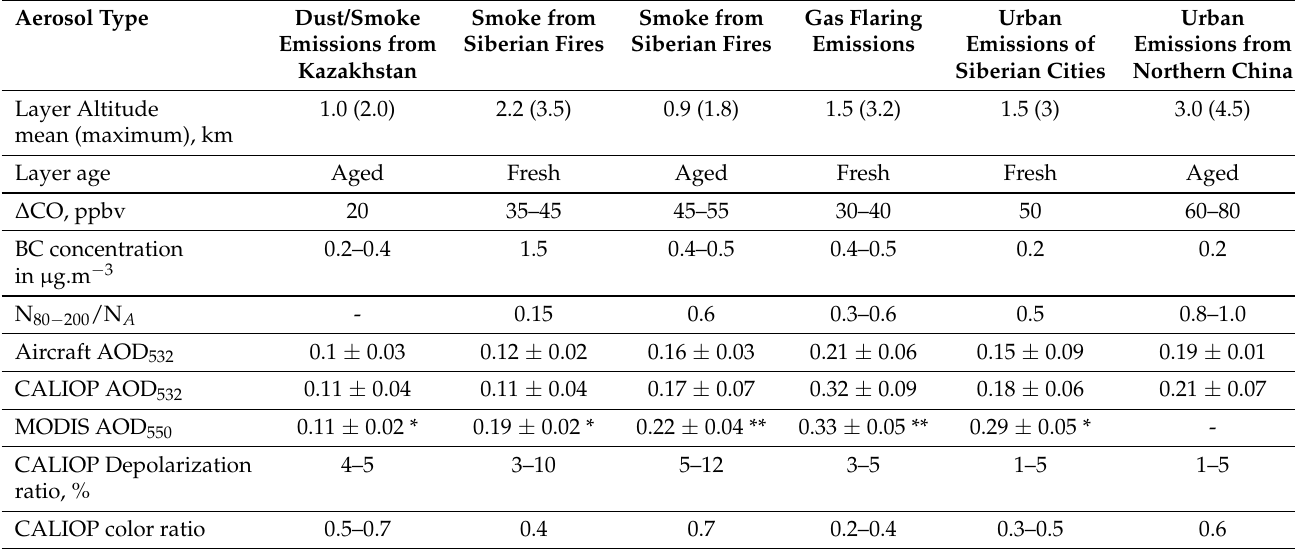
Table 1. Aerosol layer altitude, age and optical properties (AOD, color ratio, depolarization ratio) together with BC, ∆ CO concentration and N 80 − 200 /N A for the six aerosol layers selected in this